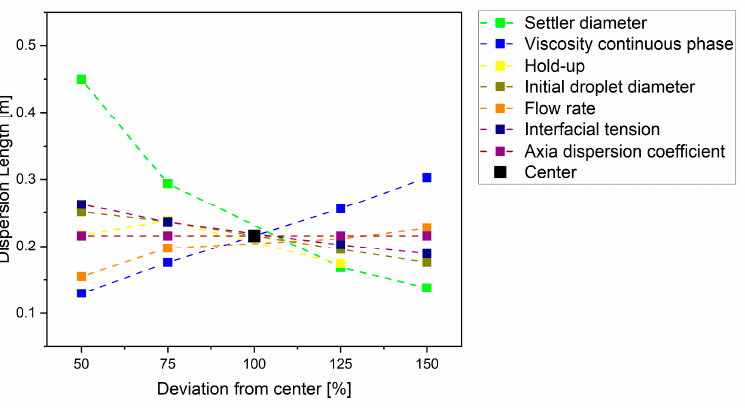
Figure 14. Presentation of the results of OFAT with wide parameter variation.